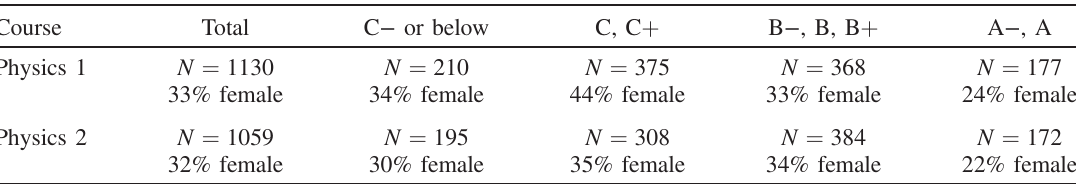
TABLE IV. The letter grade distributions for students ’ final grades in each course, including % female within each